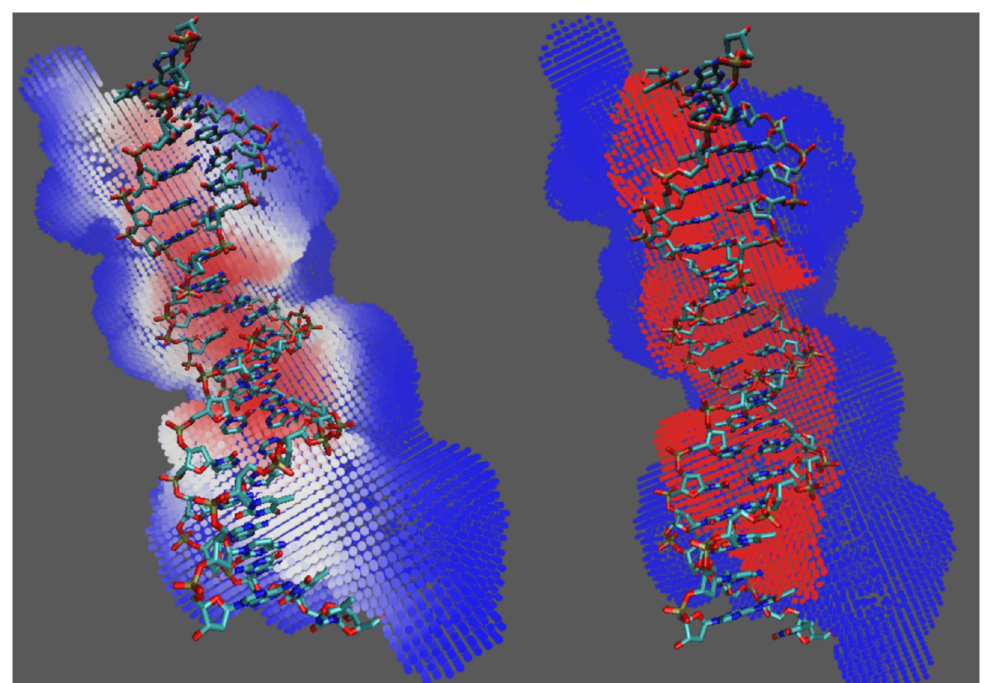
Figure 1. The relationship between the number of binding nucleotides and the MCC value of each complex.